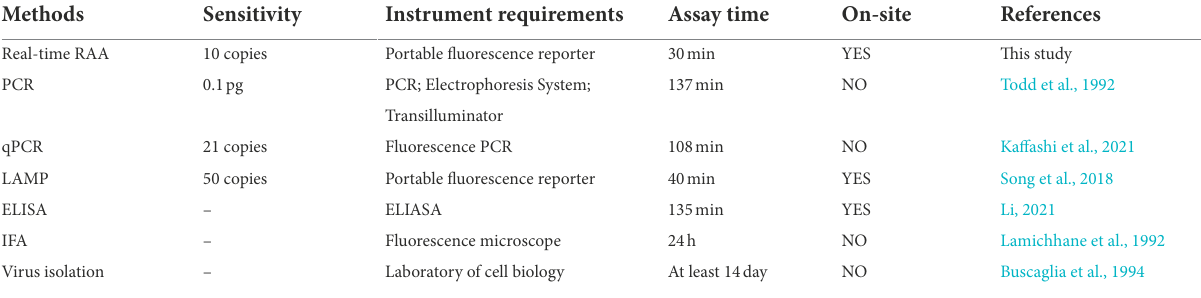
TABLE 4 Different detection methods for